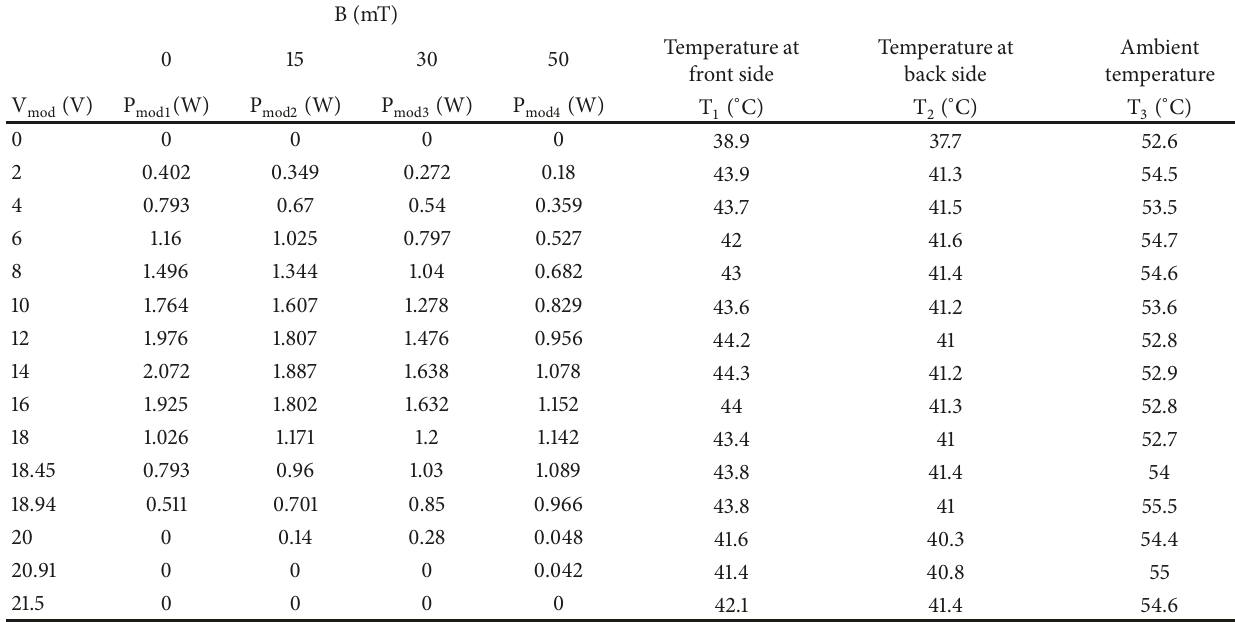
Table 3: Electric power and voltage of the photovoltaic module against the intensity of the magnetic field for a solar irradiance of 600 W/m 2 .